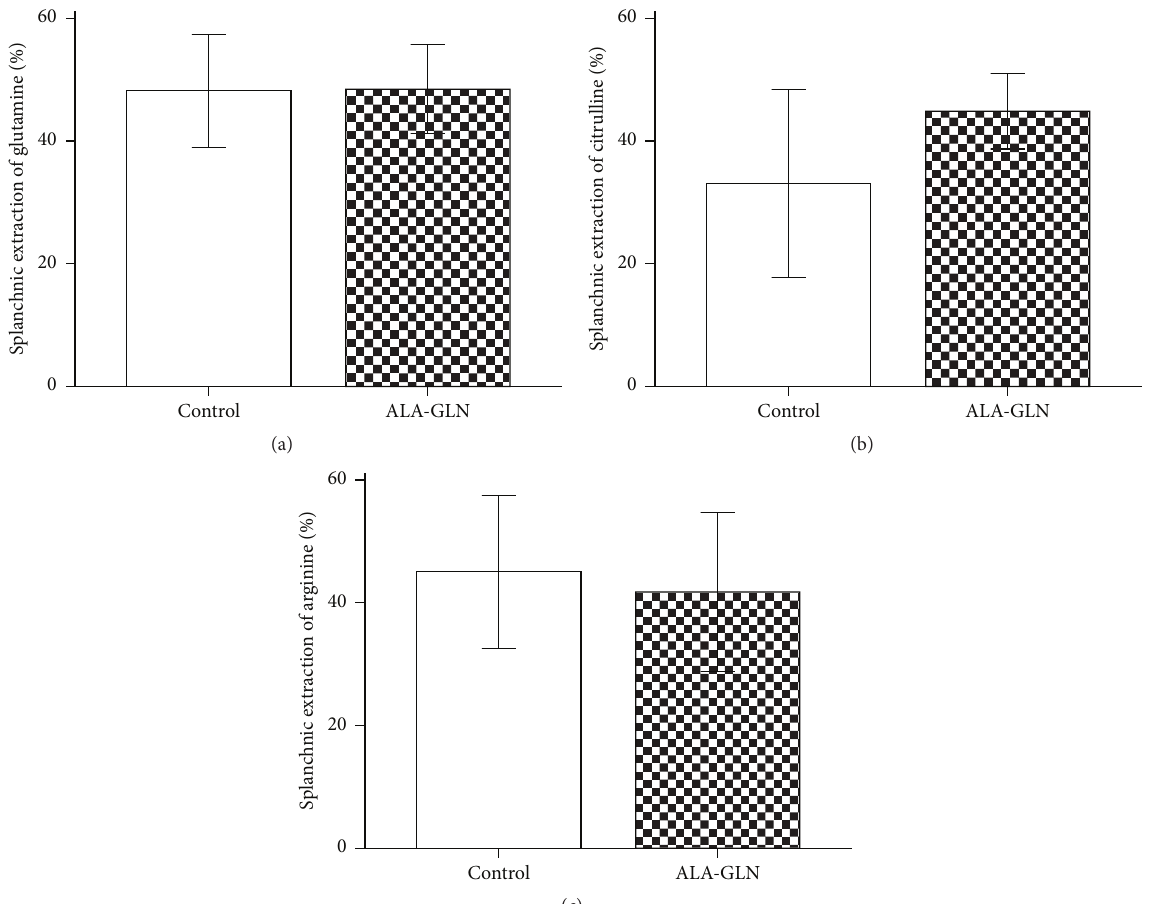
Figure 2: Splanchnic extraction: splanchnic extraction of glutamine (a), citrulline (b), and arginine (c) expressed in mean ± SE.